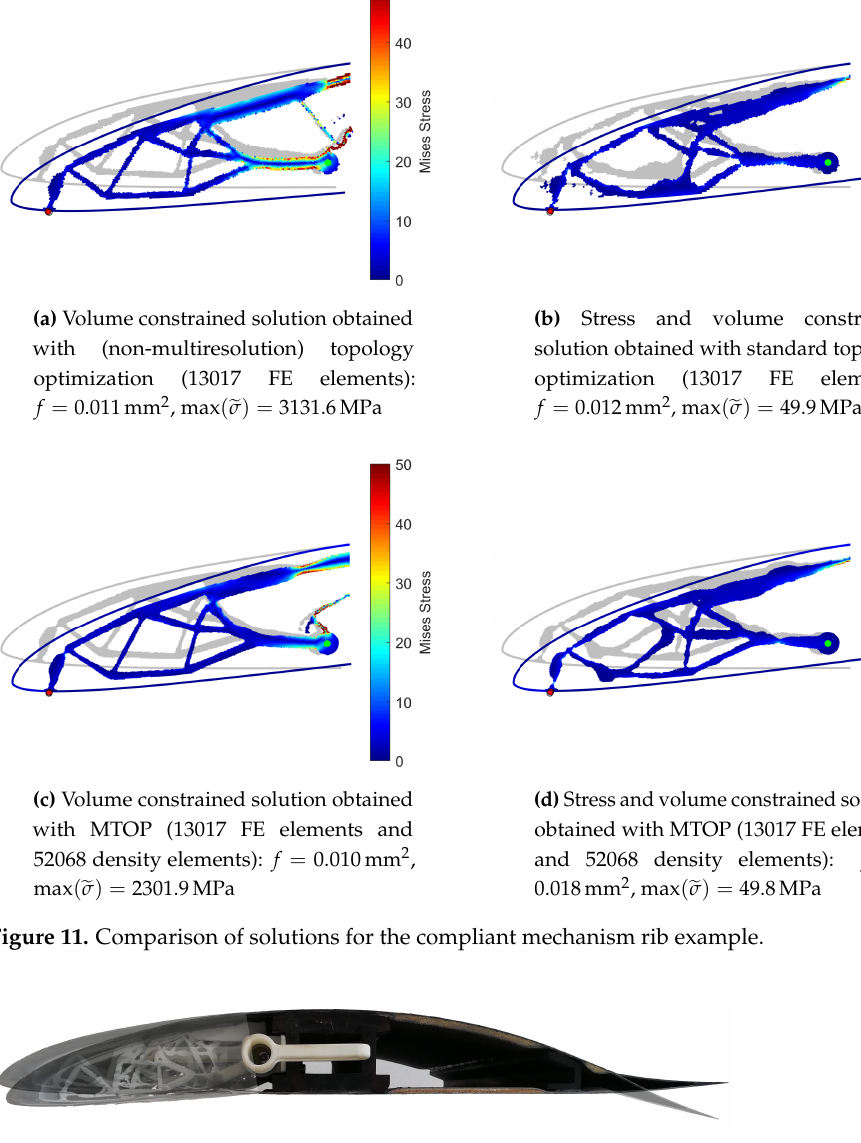
Figure 12. Morphing wing demonstrator based on topology optimization results showing unde- formed and deformed